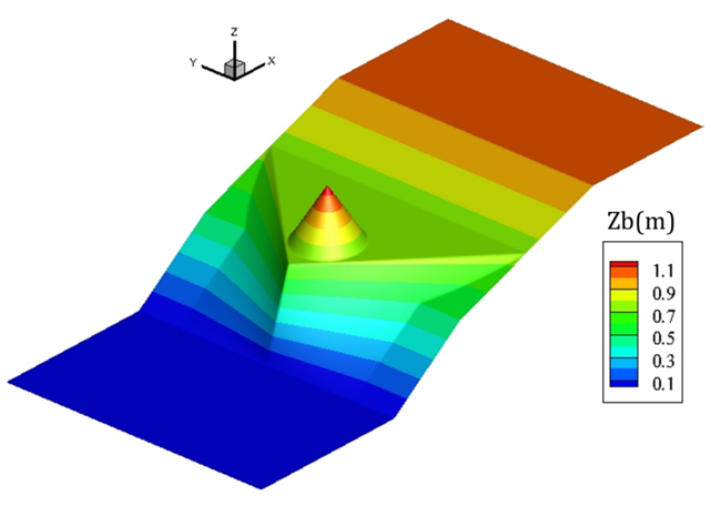
Figure 13. The geometry in Swigler’s (2009) experiments.